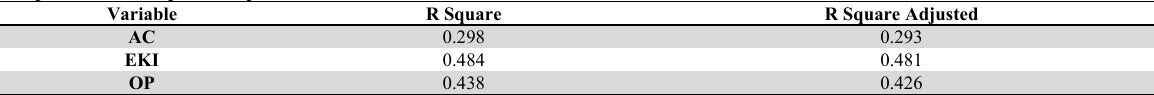
R-Square and R Square Adjusted Variable R Square R Square Adjusted